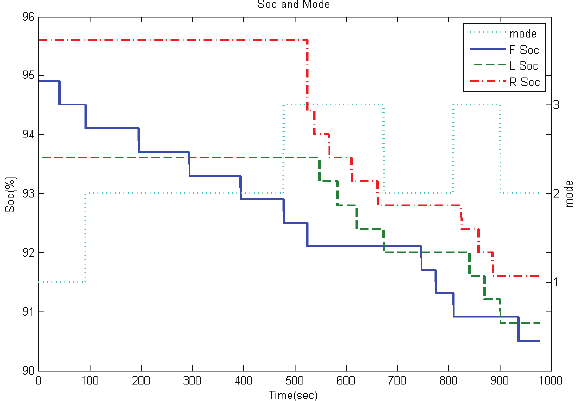
vehicle alternatively, so that the SOC gap would always remain in 1% as expected.